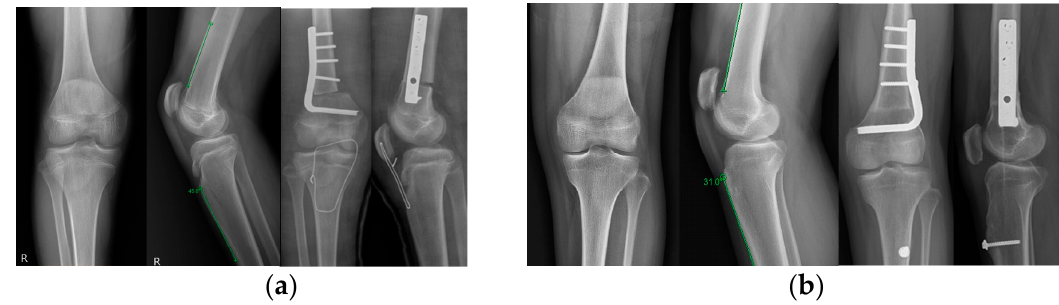
Figure 2. Preoperative and postoperative anteroposterior and lateral radiographs of the knee joints showing distal femoral shortening osteotomy fixed with a blade plate and correction of patella alta with patella tendon shortening and tension-band wiring ( a ) or tibial tubercle advancement ( b ),